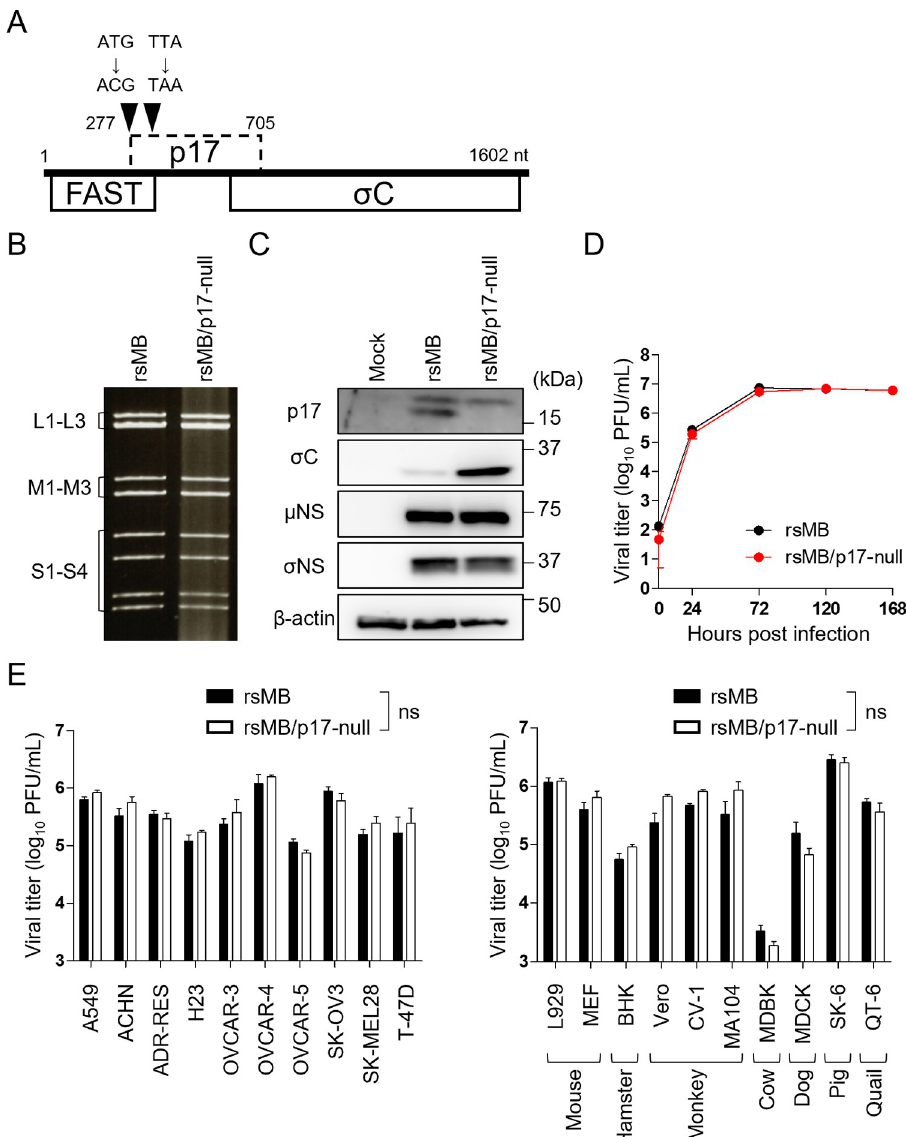
Fig 1. Evaluation of viral replication following wild-type and p17-null virus infection. (A) Schematic presentation of the S1 gene segment of rsMB and rsMB/p17-null. Three ORFs, FAST (27–314 nt), p17 (277–705 nt), and σ C (572– 1567 nt), are encoded on the NBV S1 gene segment. In the p17-null virus, the p17 start codon is disrupted with a 277 ATG 279 ! ACG substitution, and a stop codon introduced by a 301 TTA 303 ! TAA substitution. (B) The electropherotype of the genomic RNA of rsMB and rsMB/p17-null. RNA extracted from virions was electrophoresed on a 10% polyacrylamide gel. (C) Electrophoretic analysis of viral proteins of rsMB and rsMB/p17-null. Vero cells were infected with rsMB or rsMB/p17-null at an MOI of 5 PFU/cell and lysed at 18.5 h post-infection. Cell lysates were subjected to immunoblotting using antibodies raised against NBV p17, NBV σ C, NBV μ NS, NBV σ NS, or β -actin. (D) Growth kinetics of rsMB and rsMB/p17-null in Vero cells. The cells were infected with rsMB or rsMB/p17-null at an MOI of 3 PFU/cell (n = 3). Viral titers were determined by plaque assay using L929 cells. (E) Viral titers of rsMB and rsMB/p17-null in human and animal cell lines. Cells were infected with rsMB or rsMB/p17-null at an MOI of 0.1 PFU/ cell and collected at 72 h post-infection (n = 3). Viral titers were determined by plaque assay using L929 cells. Results are expressed as the mean of three samples. Error bars indicate standard deviations. ns, not significant (Welch’s t -test, p > 0.01).